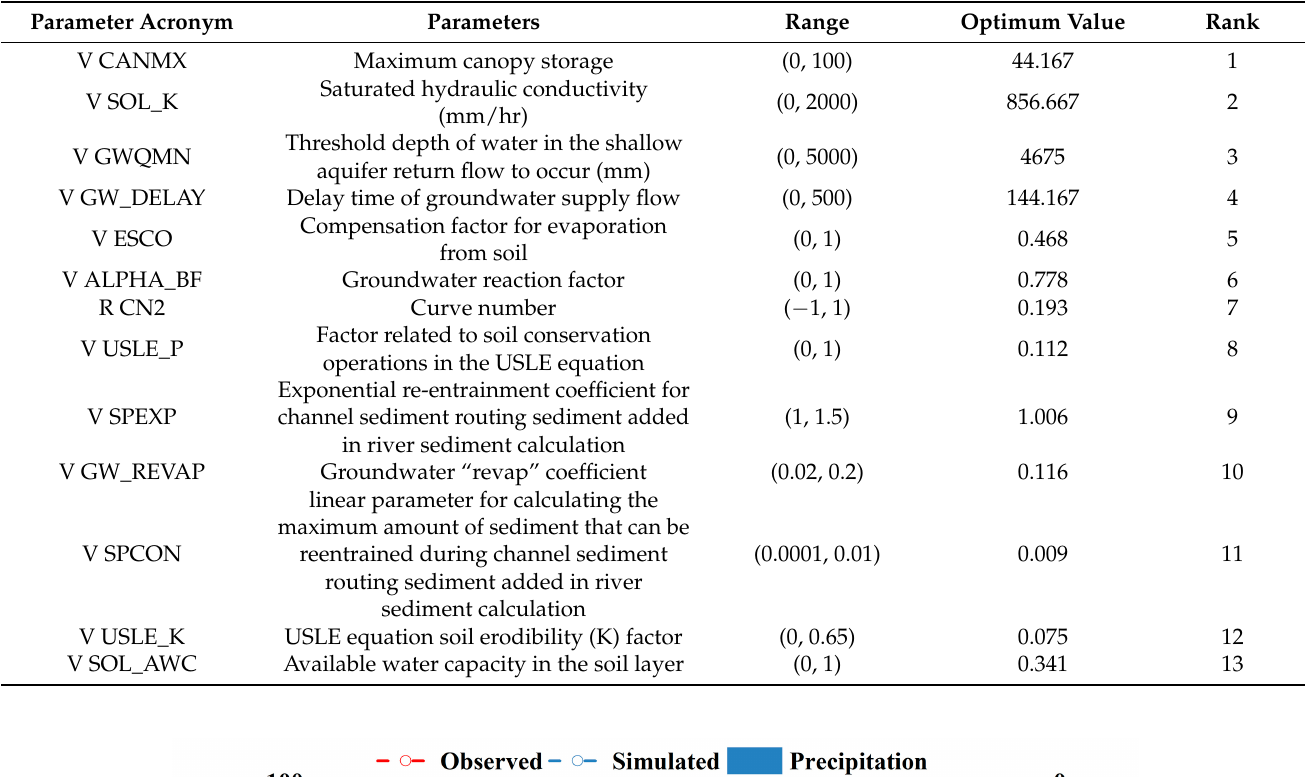
Table 2. Runoff and sediment load sensitive parameters in the Huangfuchuan Watershed.